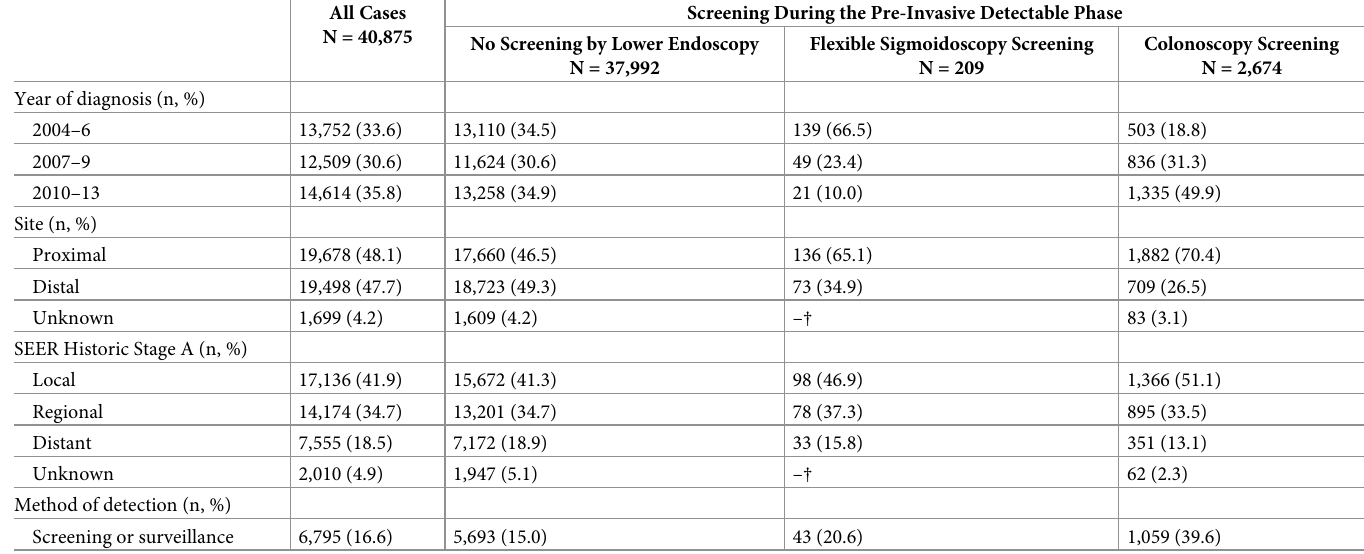
Table 2. Characteristics of colorectal cancer cases diagnosed during 2004–2013, SEER-Medicare � .